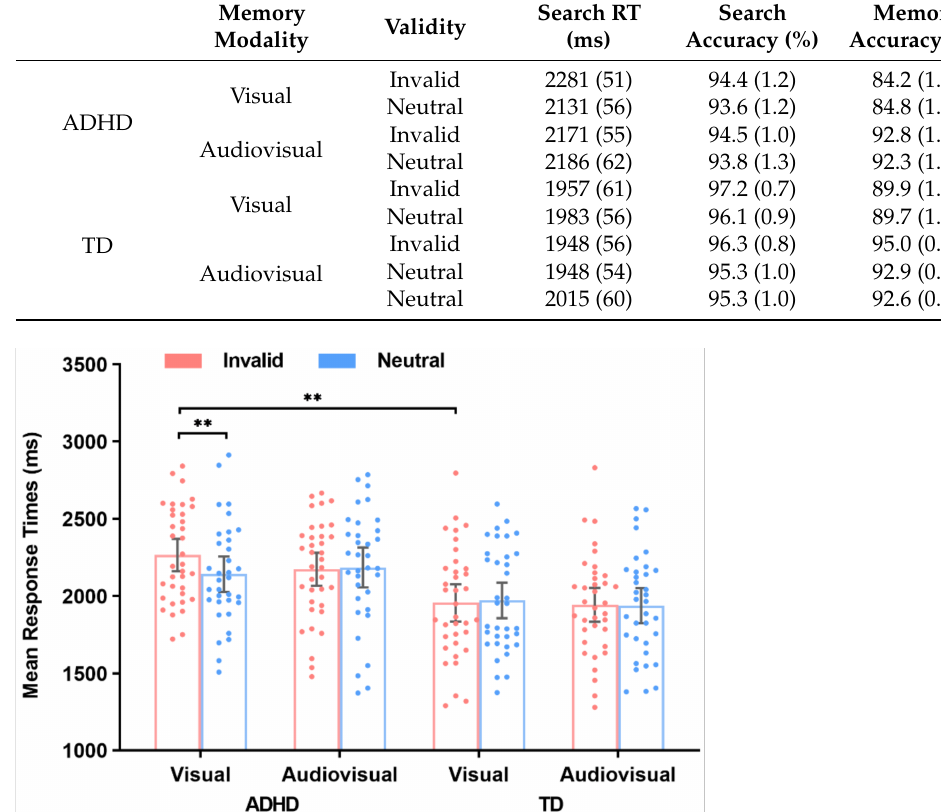
Table 1. Mean of average search RTs on correct trials and mean accuracy of search task and memory task (with standard errors in parentheses) for each condition.